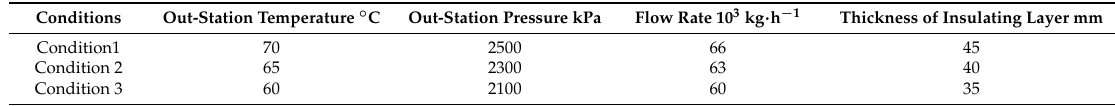
Table 2. Comparison table of parameters under different working